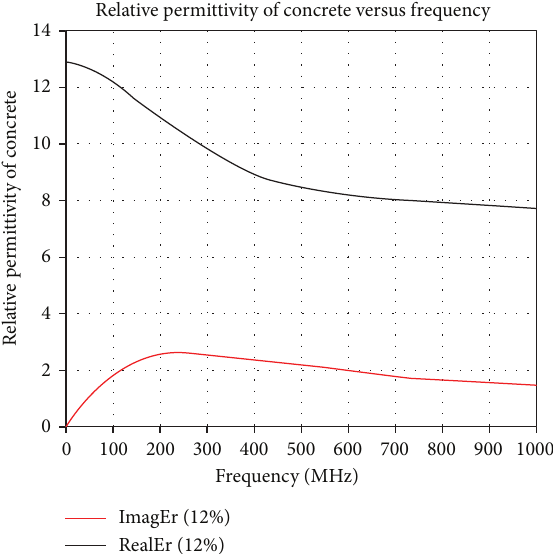
Figure 4: Relative permittivity of concrete for 12% moisture content [1, 5].